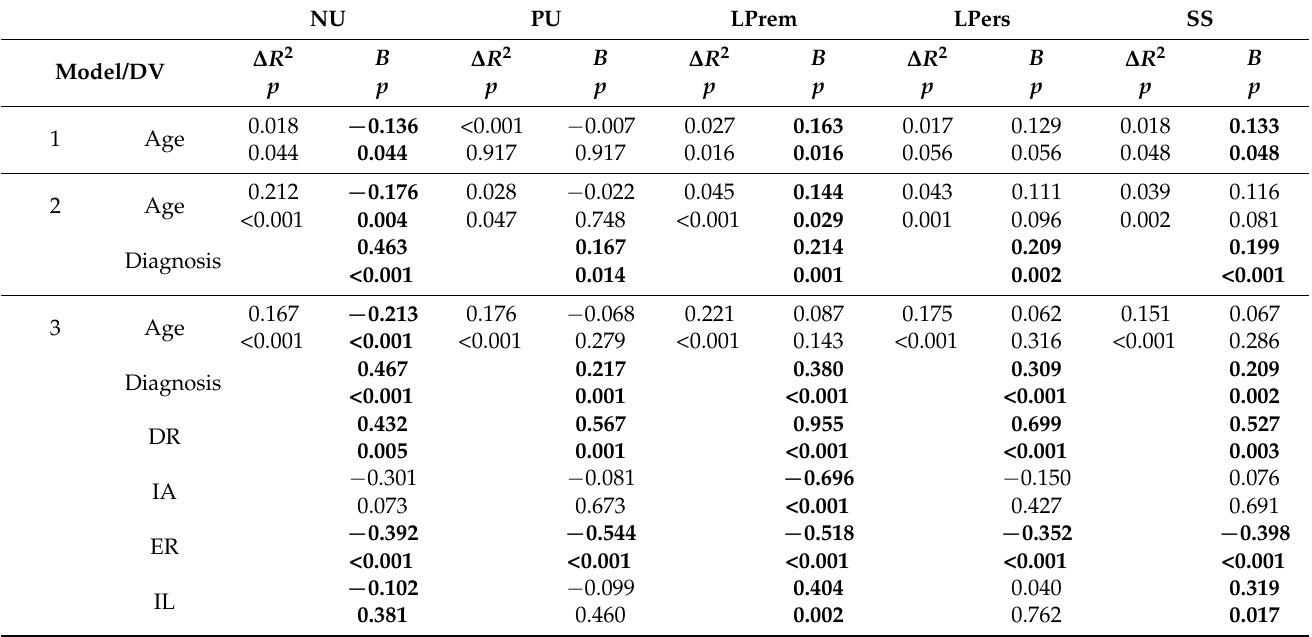
Table 3. Regression models for patients with